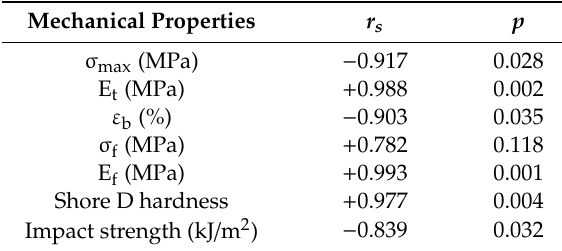
Spearman’s test correlation coe ffi cient ( r s ) and level of significance ( p ) for each mechanical